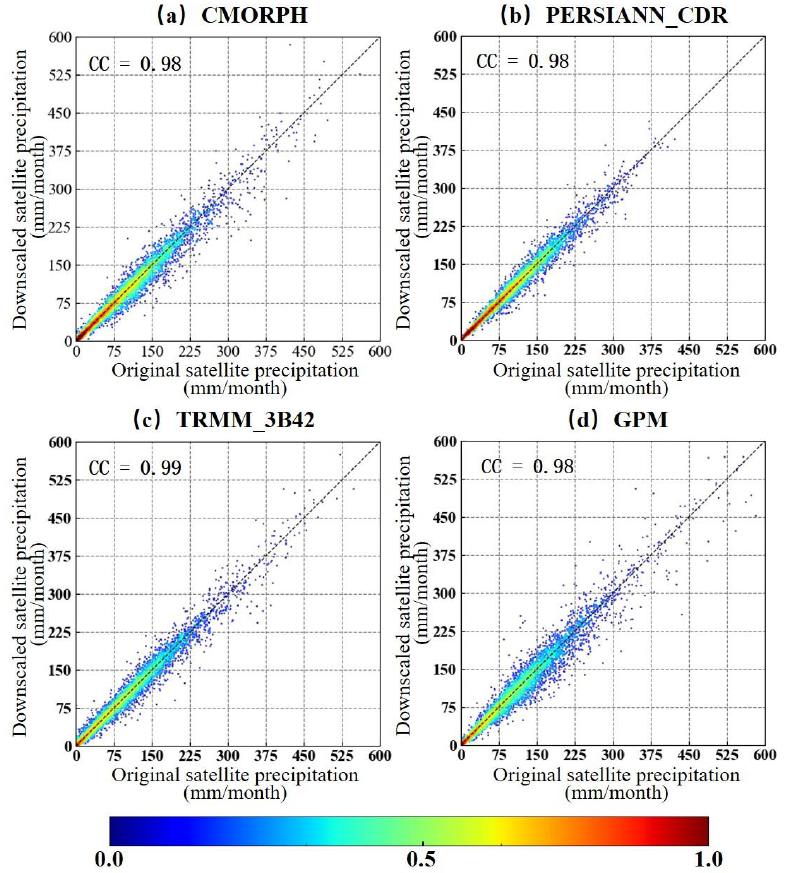
Figure 5. Scatter density plots between the downscaled monthly precipitation by the GWR model and the original satellite monthly precipitation by the GWR model: ( a ) CMORPH, ( b ) PERSIANN-CDR, ( c ) TRMM_3B42, and ( d ) GPM from 2007 to 2018.